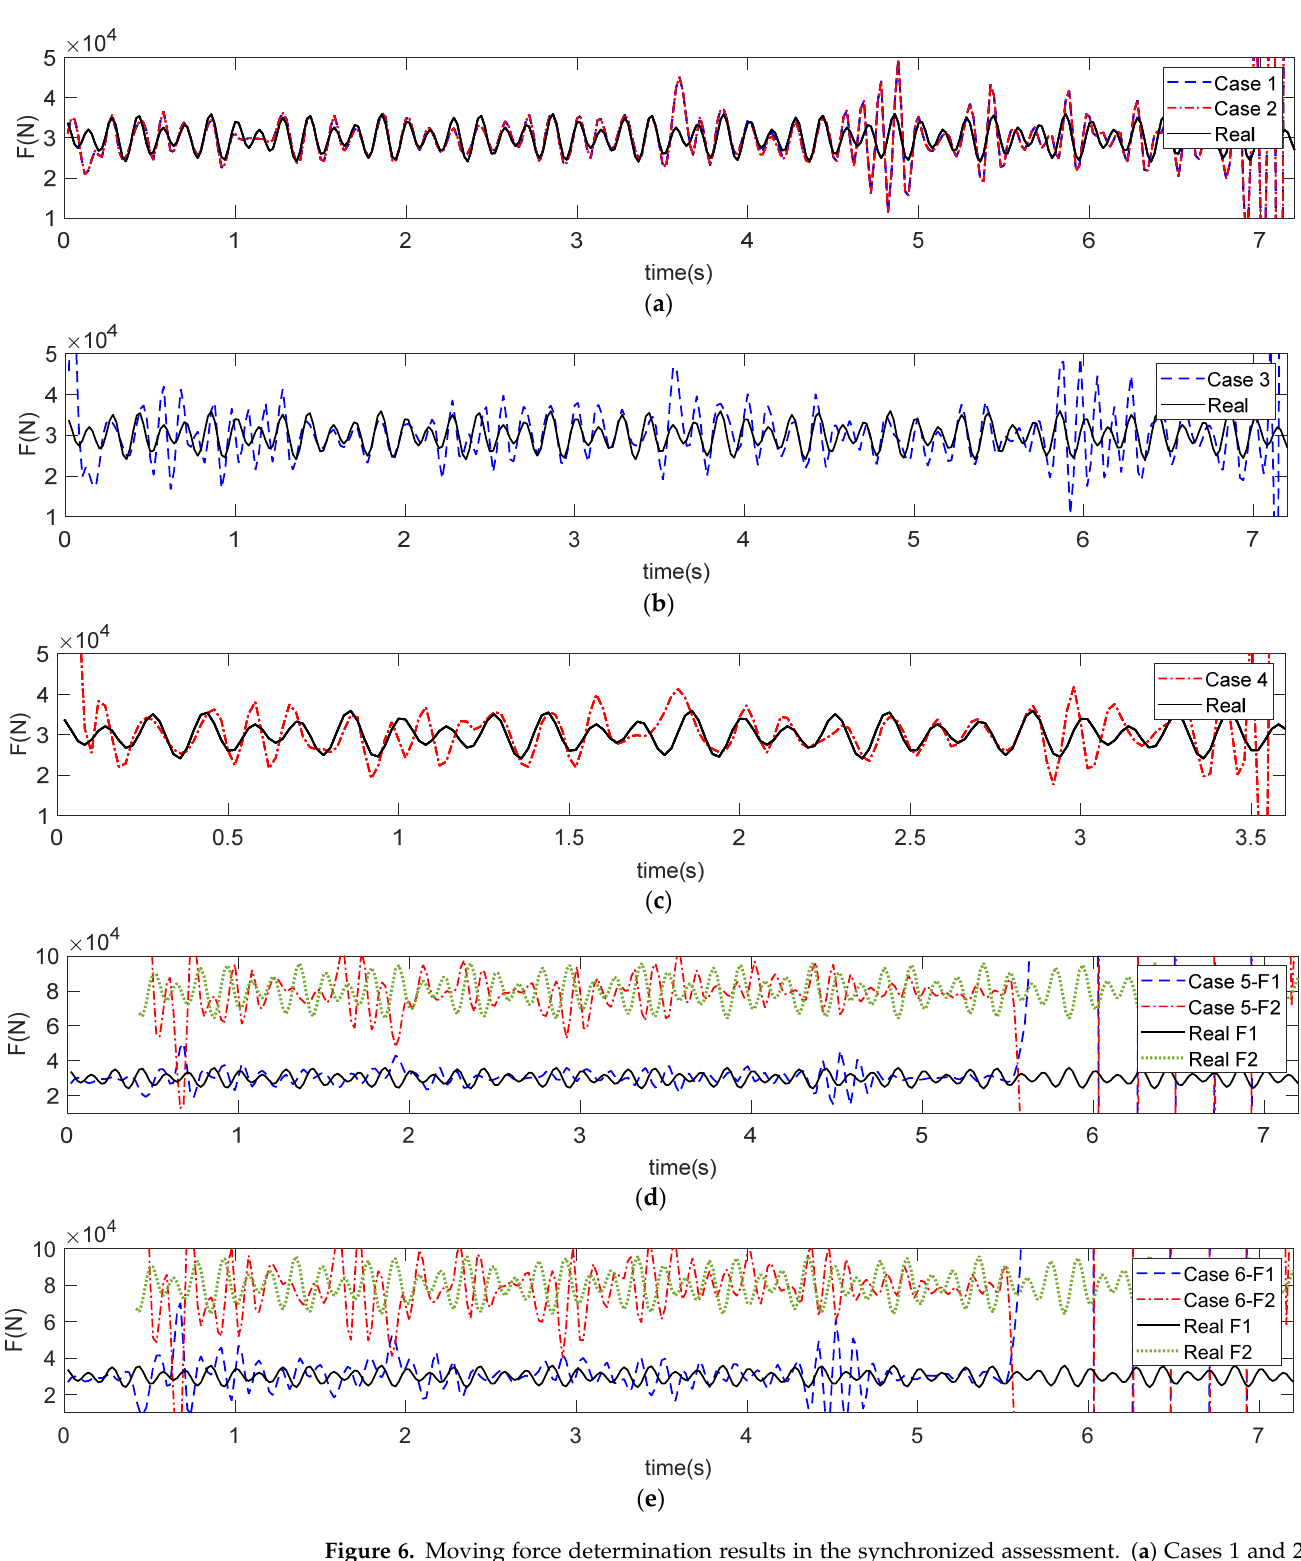
Figure 6. Moving force determination results in the synchronized assessment. ( a ) Cases 1 and 2; ( b ) Case 3; ( c ) Case 4; ( d ) Case 5; ( e ) Case 6.